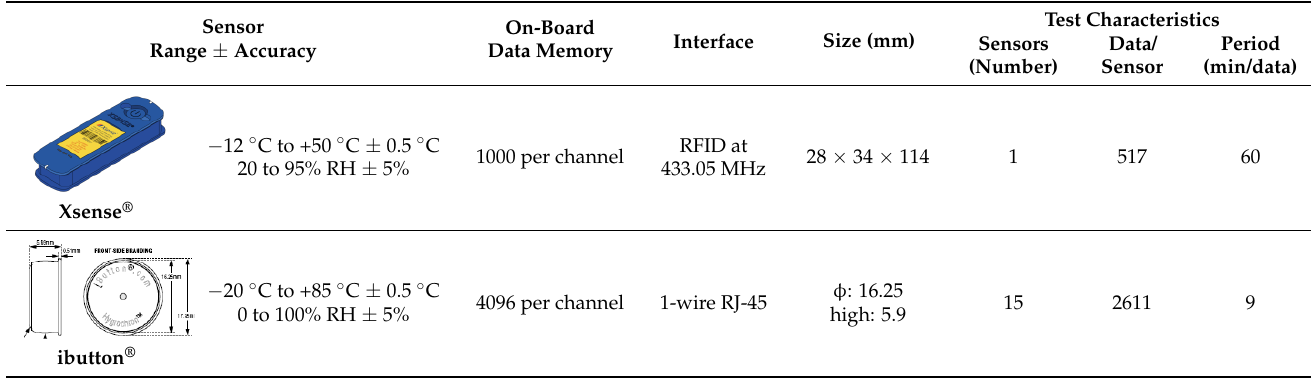
Table 2. Main characteristics of the loggers used in this experiment.